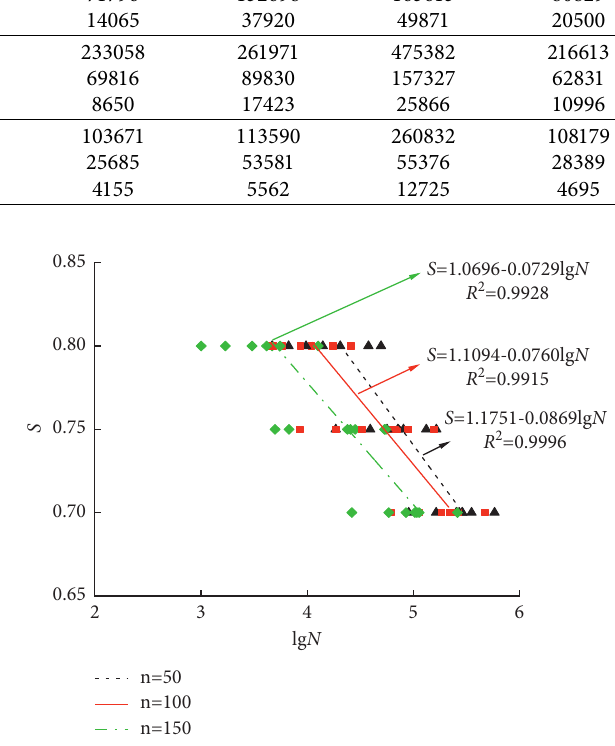
Figure 6: S- lg N curves of the average fatigue life of frost-damaged